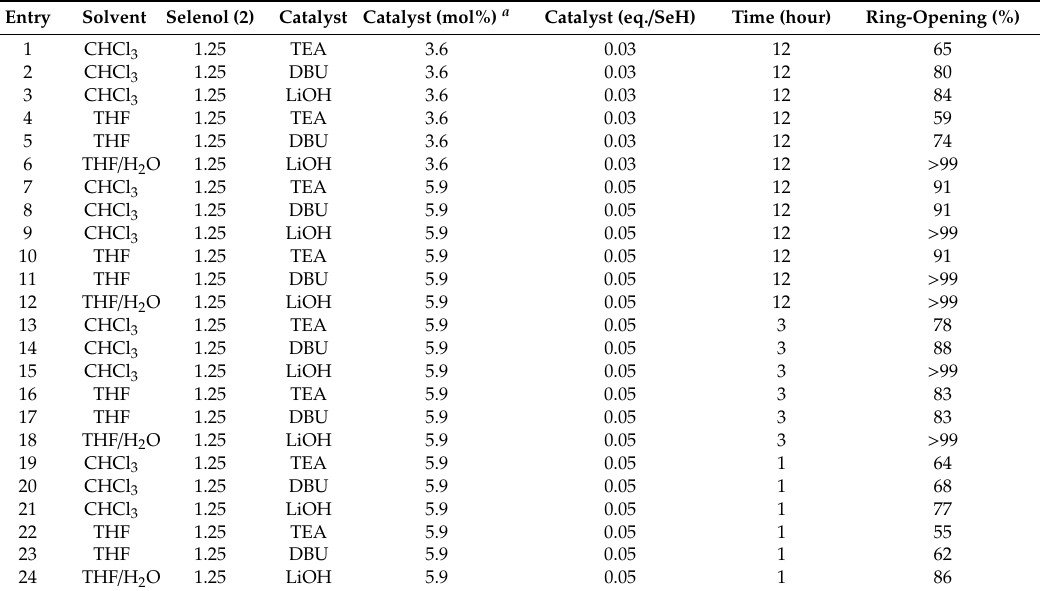
Figure 1. 1 H-NMR (DMSO- d 6 ) of 1 after ring-opening reaction. The nature of the base and the extent of ring-opening reaction are shown with each data trace. The residual solvent signals from DMSO and water are shown with the help of an asterisk. Table 1. Details of the ring-opening reaction in polymer 1